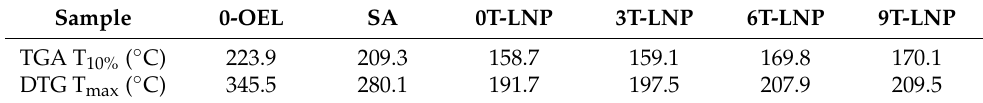
Figure 6. ( a ) TG and ( b ) DTG curves of OEL, SA, and T-LNPs. Table 3. Detailed thermal decomposition parameters for OEL, SA and T-LNPs.